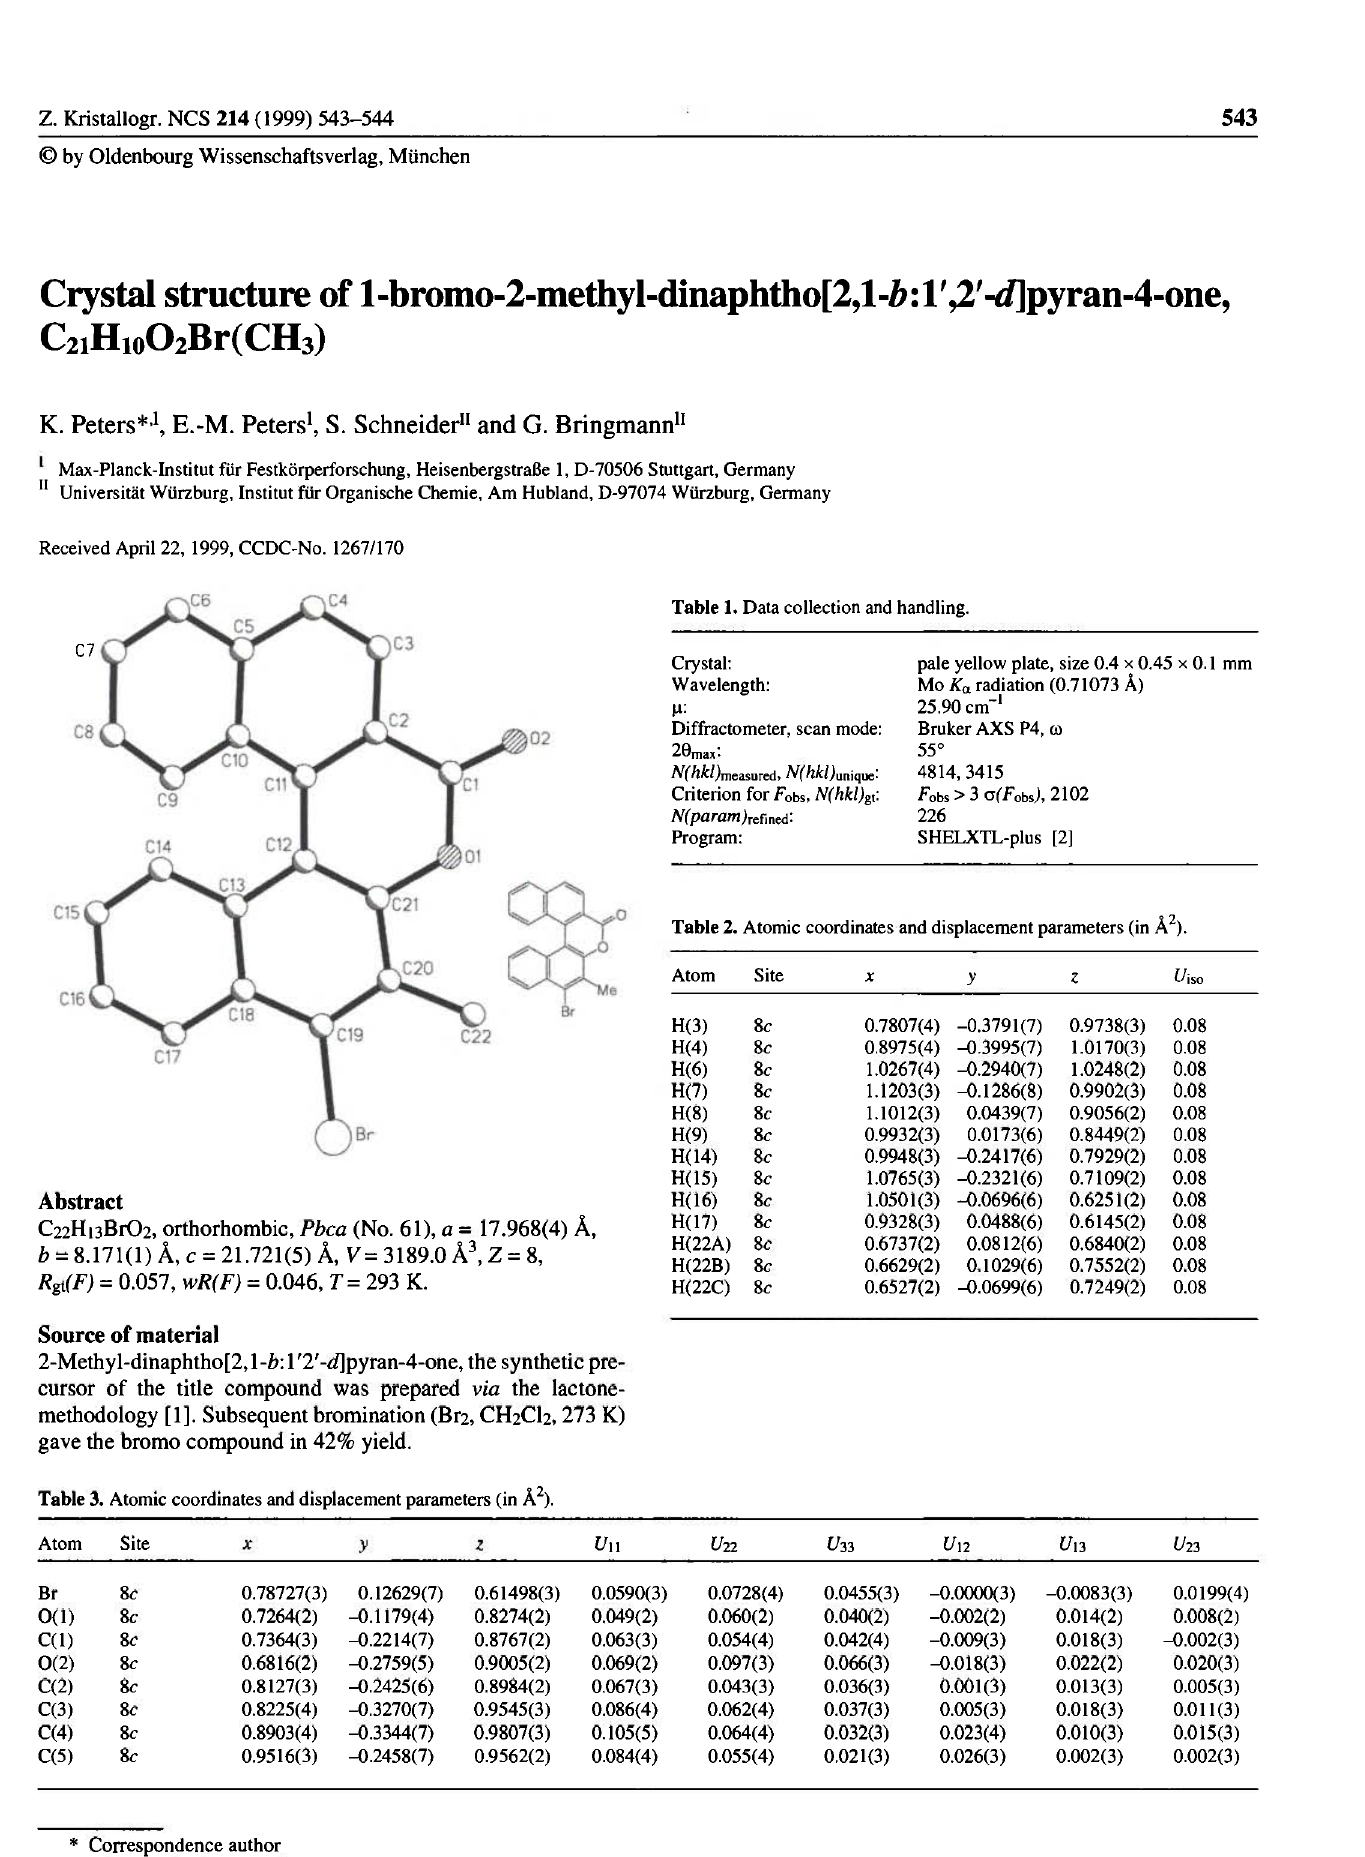
Table 3. Atomic coordinates and displacement parameters (in Ä 2 ).